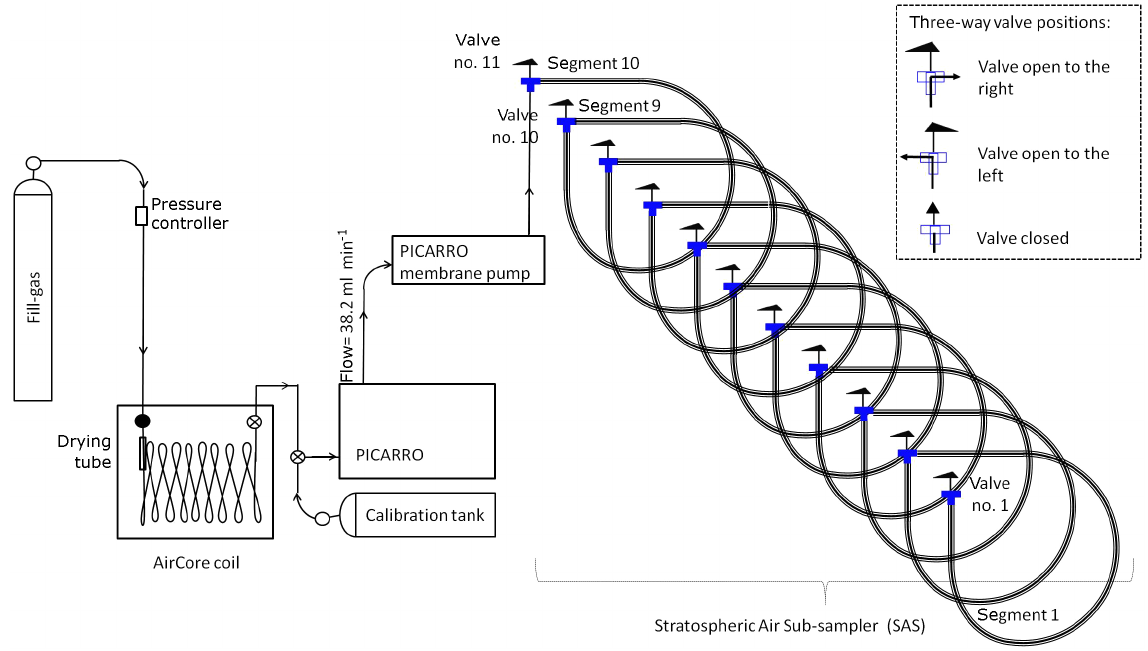
Figure 2. Schematic diagram of the analytical system for trace gas analyses with a Picarro instrument and for transferring the air from the AirCore coil into the Stratospheric Air Sub-Sampler (SAS). The three-way valves in the SAS are in “open to the right” position when the AirCore air is transferred into the SAS and closed after sub-sampling. The crossed circles are conventional valves. The open circles at the inlet of the fill-gas and the calibration-gas cylinder represent cylinder valves and pressure regulators. The black circle represents the shut-off valve at the end of the AirCore coil. The drying tube is filled with magnesium perchlorate (Mg(ClO 4 ) 2 ) from Sigma-Aldrich.